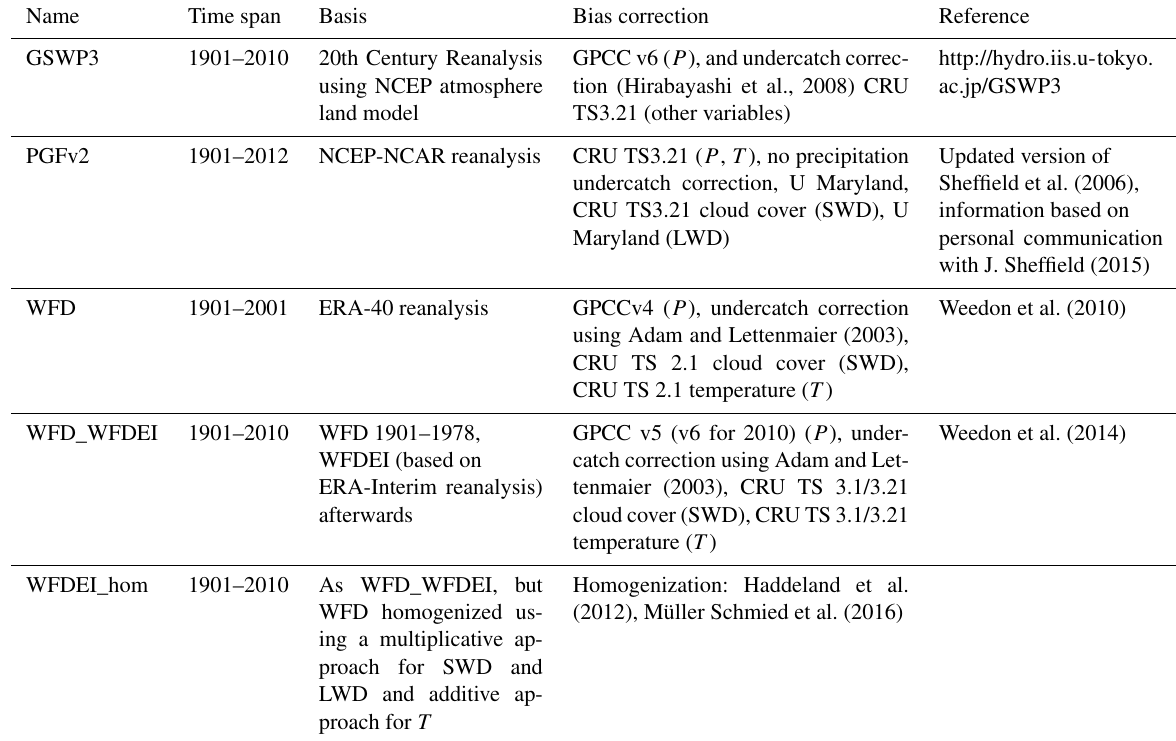
Table 1. Summary of climate forcing characteristics used in this study. Abbreviations: precipitation – P , temperature – T , shortwave down- ward radiation – SWD, longwave downward radiation –